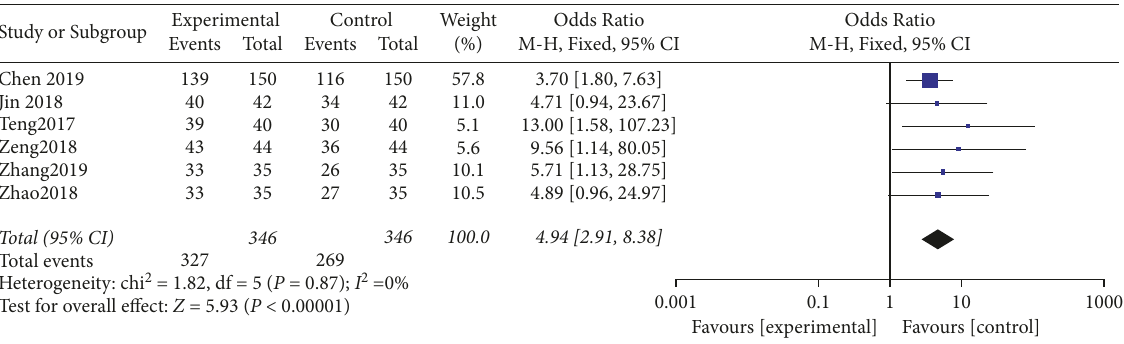
Figure 4: Forest analysis map of the comparison of treatment